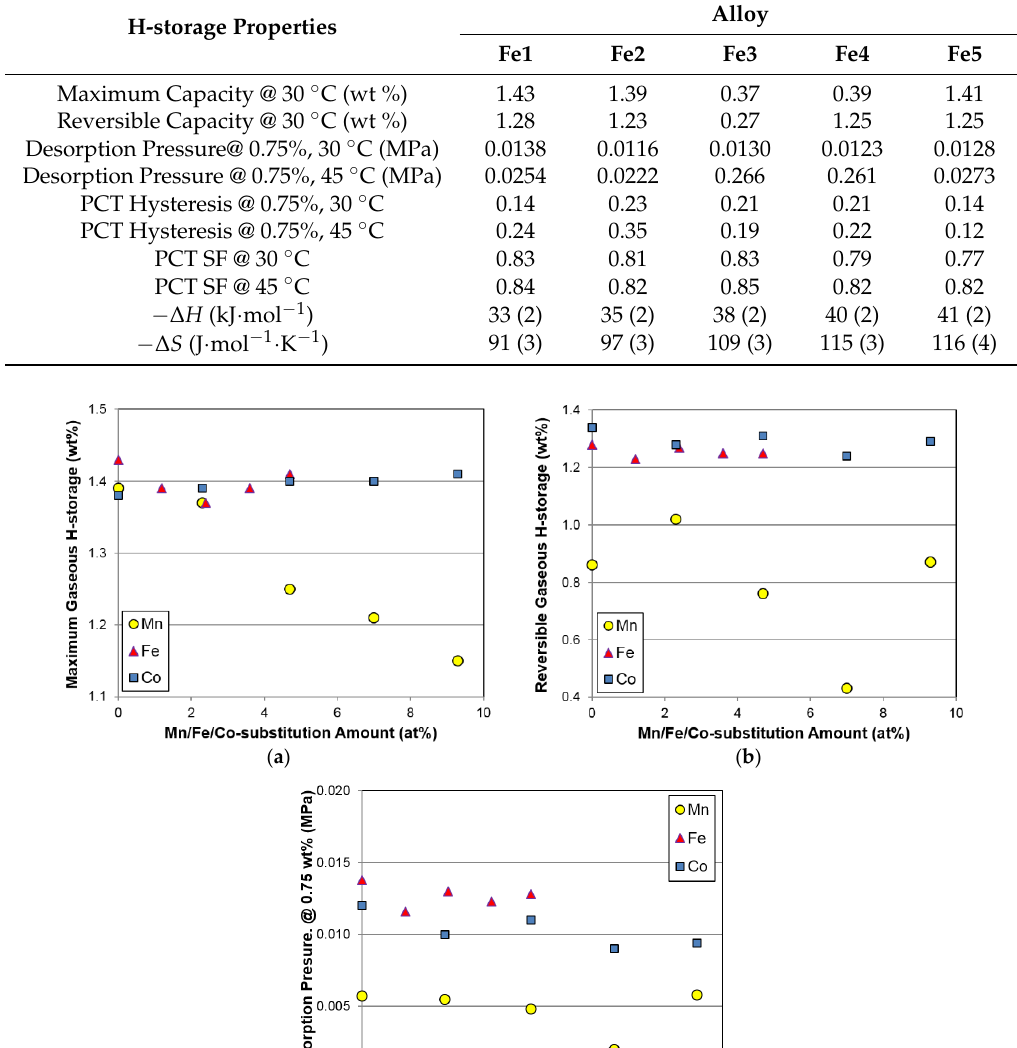
Table 4. Summary of gaseous phase hydrogen storage (H-storage) properties. Error ranges are indicated in parentheses after the quantity. PCT: pressure-concentration-temperature; and SF: slope factor.